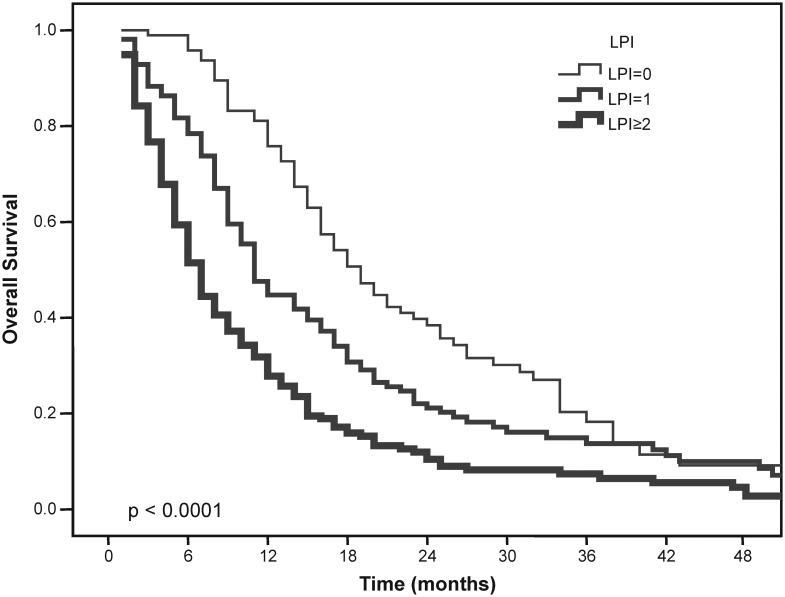
Overall survival of patients according to LPI.